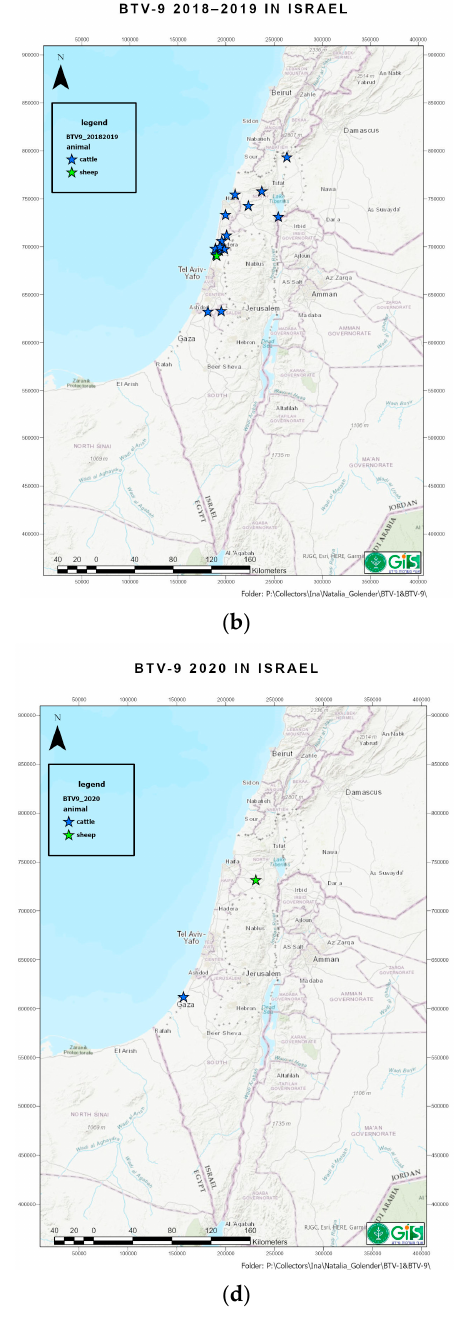
Figure 1. Distribution of BTV-1 and BTV-9 by seasons during 2018–2020. Stars show geographic settlements and type of animals where BTV was identified. ( a ) BTV-1 distribution during the end of 2019–beginning of 2020. Location of BTV-1-infected goats are not signed because BTV-1 was also identified in sheep in the same farm. ( b ) BTV-9 distribution during the end of 2018–beginning of 2019. ( c ) BTV-9 distribution during the end of 2019–beginning of 2020. ( d ) BTV-9 distribution during the end of 2020.